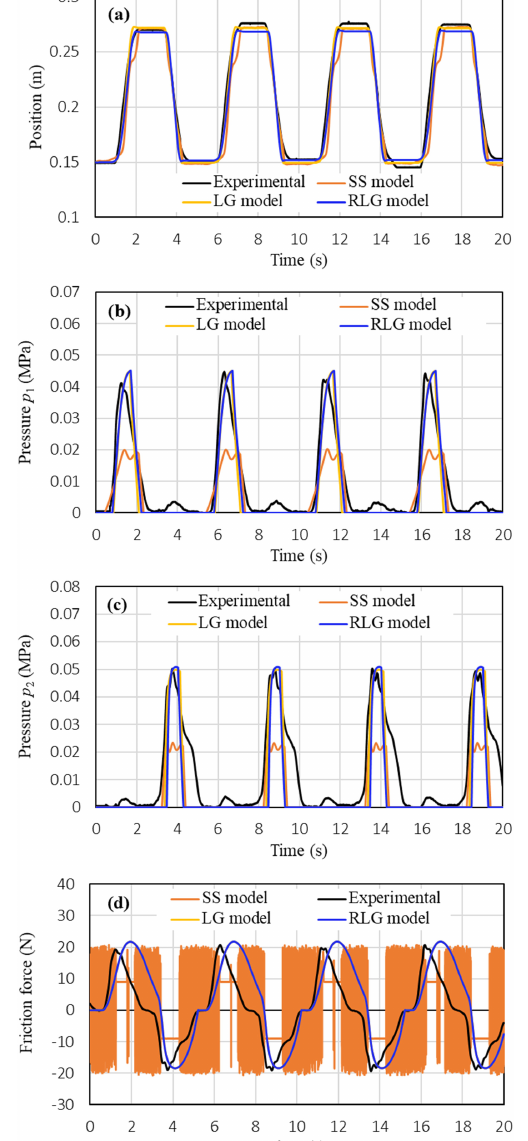
Figure 12. Comparison between measured characteristics of the piston position, pressures and friction force and those simu- lated using the three friction models: (a) position, (b) pressure p 1 , (c) pressure p 2 , (d) friction force ( M = 0 . 5kg, u 1 = 2 . 5 + 0 . 5sin(2 πf t )(V), u 2 = 2 . 5 − 0 . 4sin(2 πf t )(V), f =